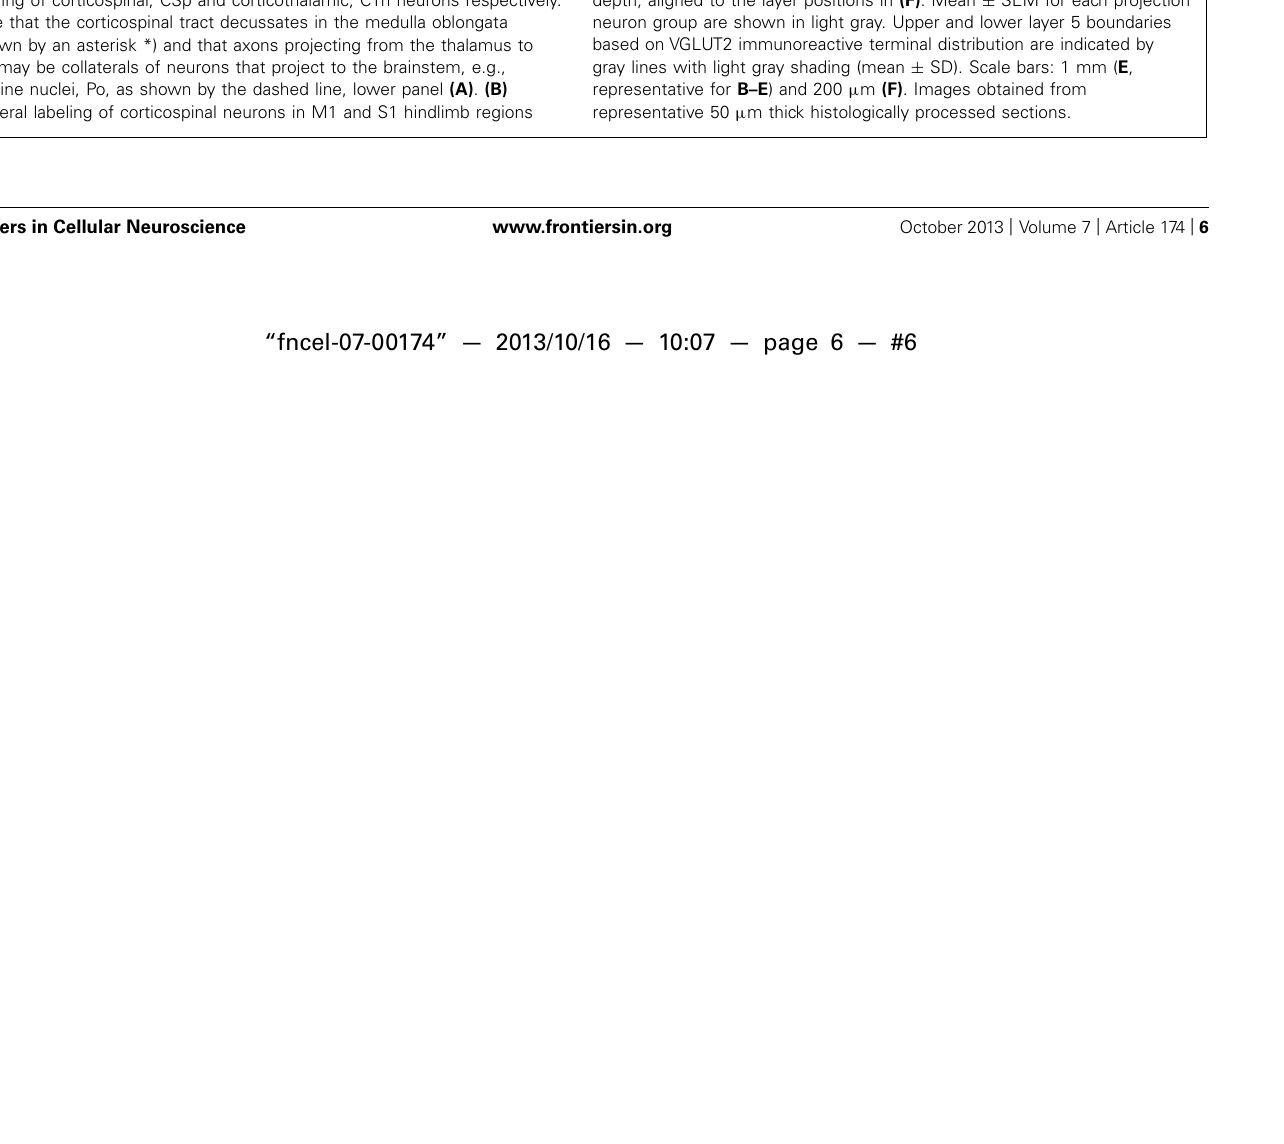
following a unilateral cholera toxin B (CTB) injection into the lumbar spinal cord (inset). (C) Homotopic M1 labeling contralateral to the CTB injection site in M1. (D) Widespread cortical bilateral labeling following CTB injection into the dorsolateral striatum in the left hemisphere (contrast was enhanced for the right hemisphere). (E) Widespread labeling of layer 5 and 6 neurons following ipsilateral CTB injection into the ventrolateral thalamic nucleus. (F) Laminar profile of VGLUT2 immunoreactive terminals and distribution of the retrogradely labeled neurons in M1, from the different sites, in slices of M1 obtained from similar bregma levels. (G) Soma position of all individually patch-clamped retrograde labeled neurons normalized by cortical depth, aligned to the layer positions in (F) . Mean ± SEM for each projection neuron group are shown in light gray. Upper and lower layer 5 boundaries based on VGLUT2 immunoreactive terminal distribution are indicated by gray lines with light gray shading (mean ± SD). Scale bars: 1 mm ( E , representative for B–E ) and 200 μ m (F) . Images obtained from representative 50 μ m thick histologically processed